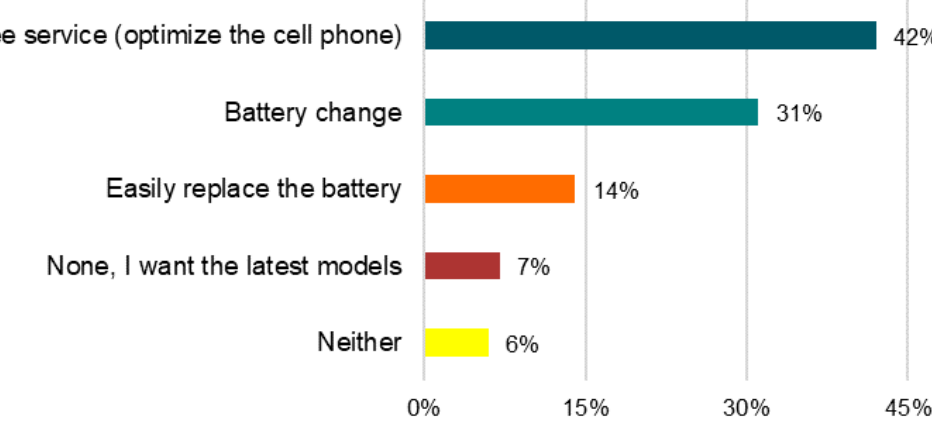
Figure 6. Options to keep mobile phones longer than expected (percentages). Source: Own elaboration based on the results obtained from the national survey (2018).